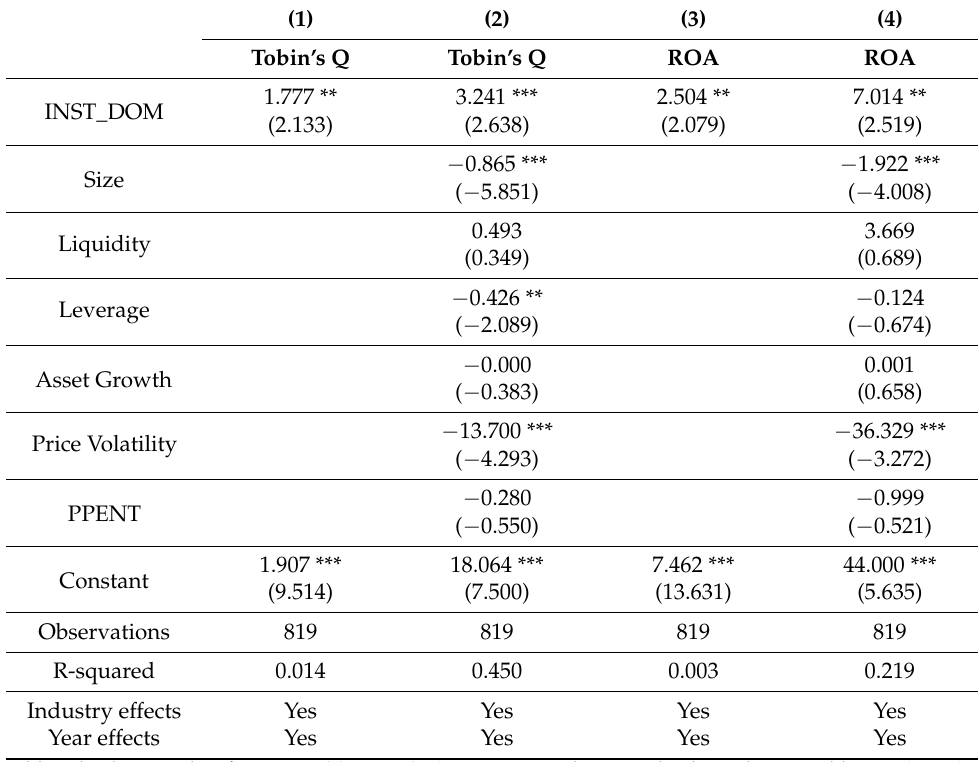
Table 4. Impact of Domestic Institutional Ownership and Firm